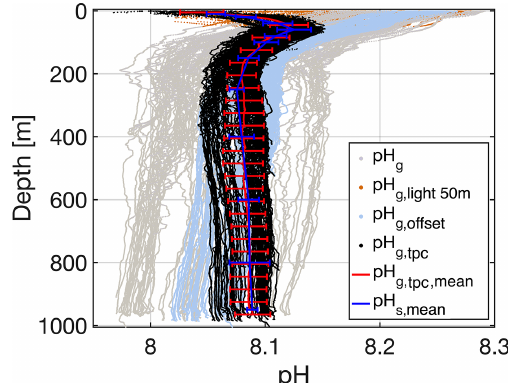
Figure 11. Profiles of glider-retrieved pH (pH g ) pre-correction (grey) with a depth-constant time-varying offset correction applied (light blue) and further corrected for in situ temperature and pres- sure (black). The pH g measurements affected by light in the top 50m of the water column (orange) and not used for the drift; tem- perature and pressure corrections are also shown. The depth-binned mean profile of drift, temperature, and pressure-corrected (tpc) pH g (using 10m bins) is shown in the foreground (red) along with the standard deviation ranges displayed every 40m in this figure. The depth-binned mean profile of the pH measurements retrieved by ship (pH s ) is plotted for comparison (dark blue) with standard devi- ation ranges displayed at each sampled